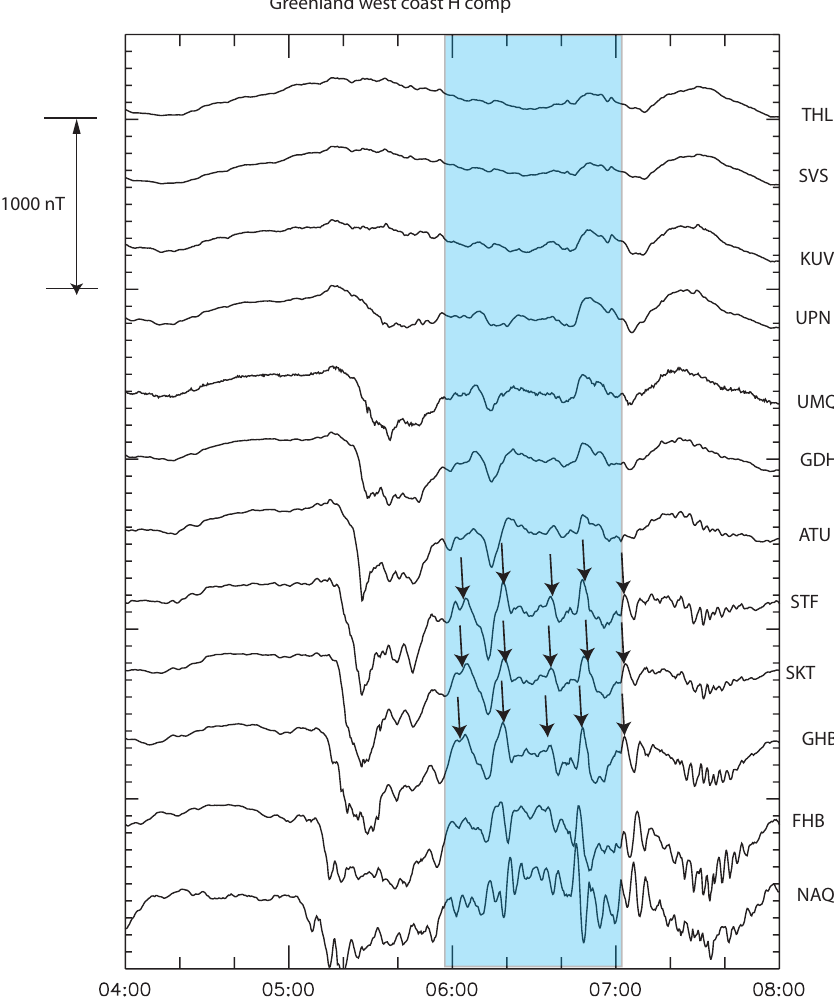
Figure 8 Fig. 8. The stacked H component data from the Greenland west coast magnetometers. It is in the order of decreasing latitude from top to